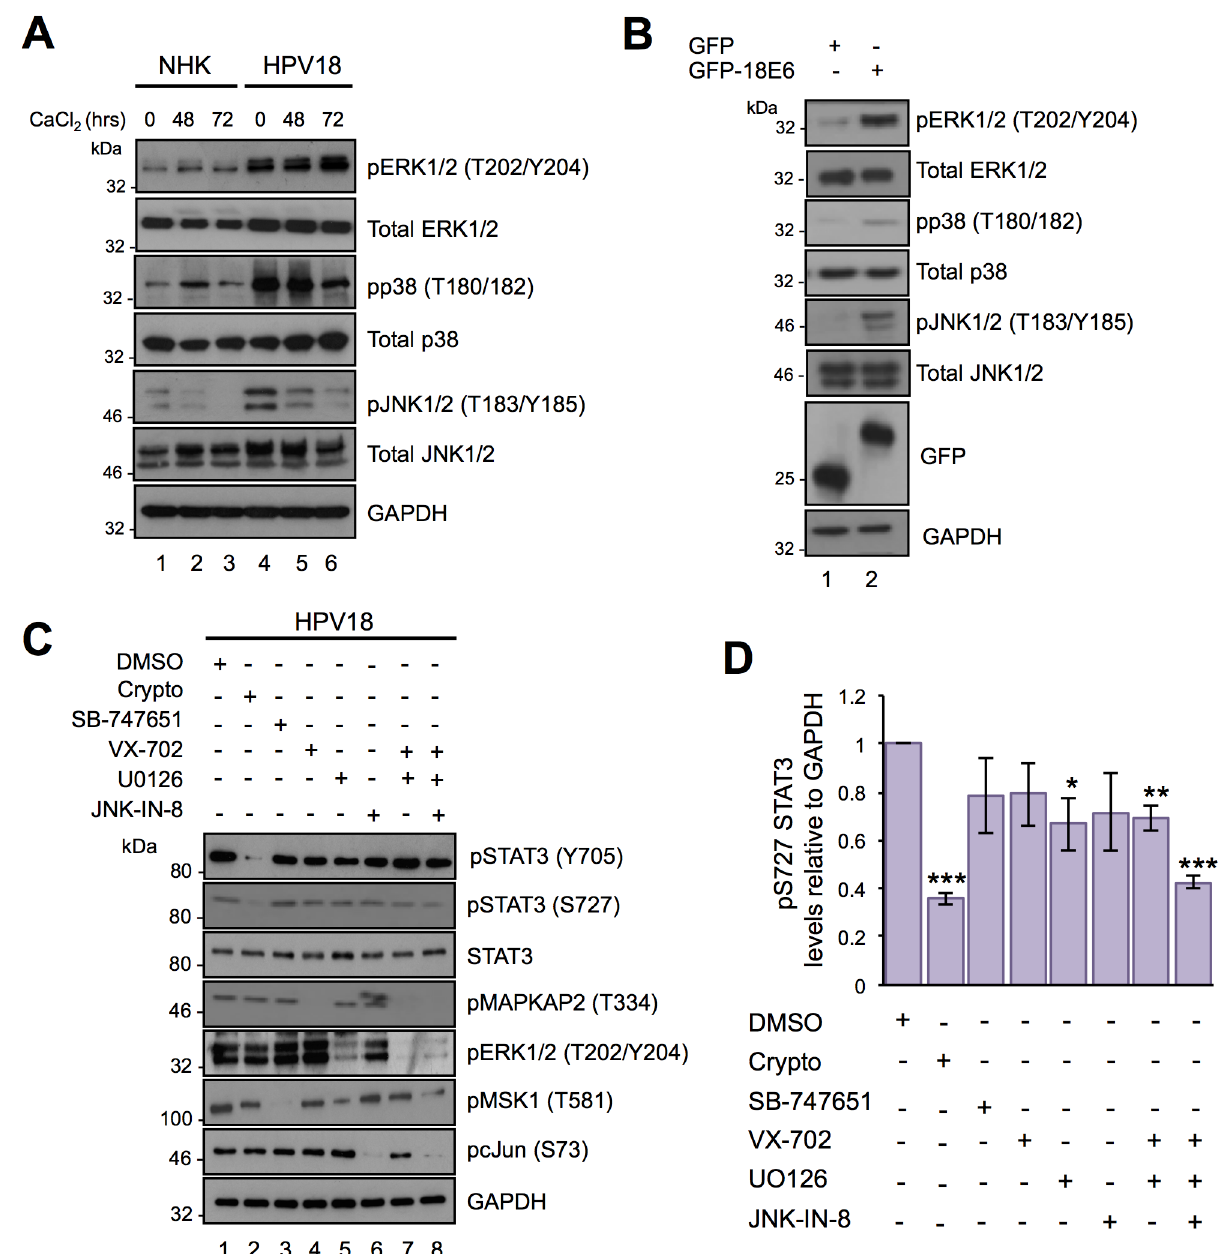
Fig 5. Identifying the protein kinases responsible for the S727 phosphorylation of STAT3 in HPV18 containing keratinocytes. A) Representative western blot of keratinocytes subjected to high calcium differentiation analysed with antibodies specific for the total and phosphorylated forms of ERK1/ 2 (Thr202/Tyr204), p38 (Thr180/Tyr182) and JNK (Thr183/Tyr185). GAPDH served as a loading control. Data shown are representative of at least three independent biological repeats. B) Representative western blot of C33a cells transfected with GFP and GFP tagged HPV18 E6 and analysed using specific antibodies detecting phosphorylated and total forms of ERK1/2 (Thr202/Tyr204), p38 (Thr180/Tyr182) and JNK (Thr183/Tyr185). GAPDH served as a loading control. C) Representative western blots of HPV18 containing keratinocytes incubated with specific inhibitors of STAT3 (Crypto), MSK1 (SB-747651A; SB), p38 (VX-745; VX)), JNK (JNK-IN-8), MKK1/2 (UO126) or in combination as described in the methods and materials and examined with antibodies specific for phosphorylated and total STAT3. The phosphorylation status of substrate proteins pMSK1 (T581), pcJun (S73), pMAPKAPK2 (T334), and ERK1/2 (T202/Y204) demonstrated inhibitor efficacy and specificity. D) Quantification of the protein band intensities of (C) standardised to GAPDH and shown relative to the DMSO control. Bars represent the means ± standard deviation from at least three independent biological repeats. (cid:3) P < 0.05, (cid:3)(cid:3) P < 0.01, (cid:3)(cid:3)(cid:3) P < 0.001 (Student’s t-test).